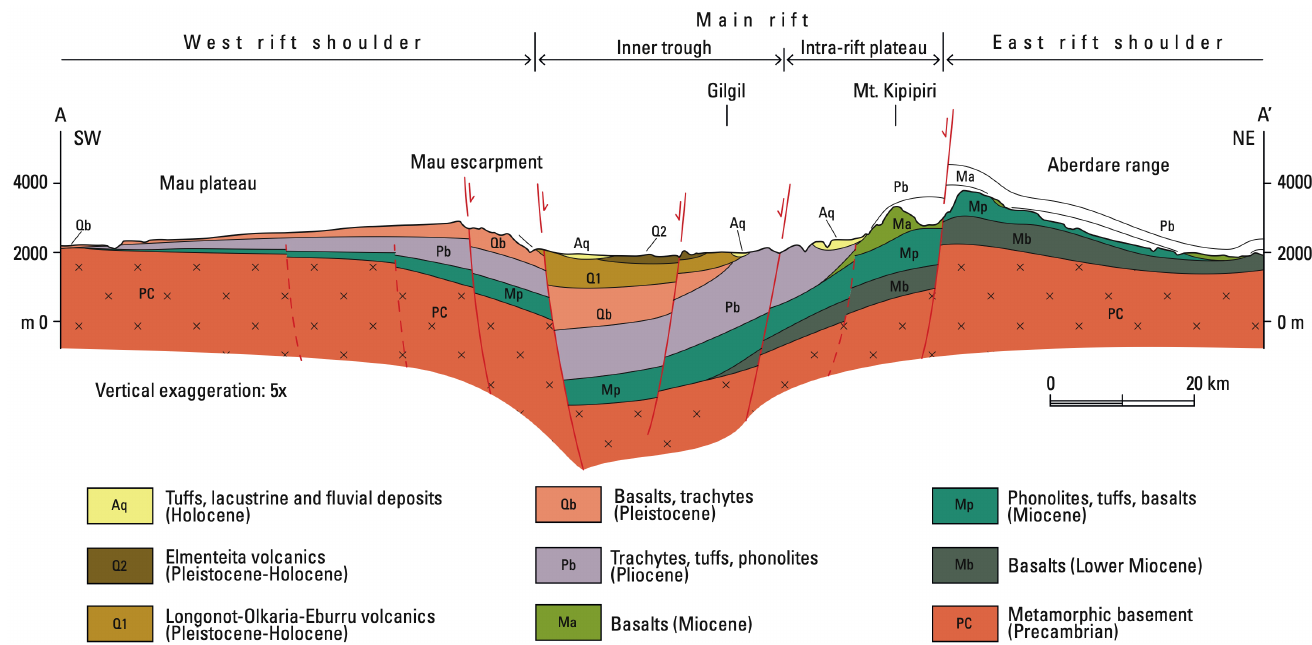
Figure 4. Geological cross-section in the Kenya rift, section trace in Figure 3, based on Baker et al. [35], Smith [36], Roessner and Strecker [26], Simiyu and Keller [37], and original field